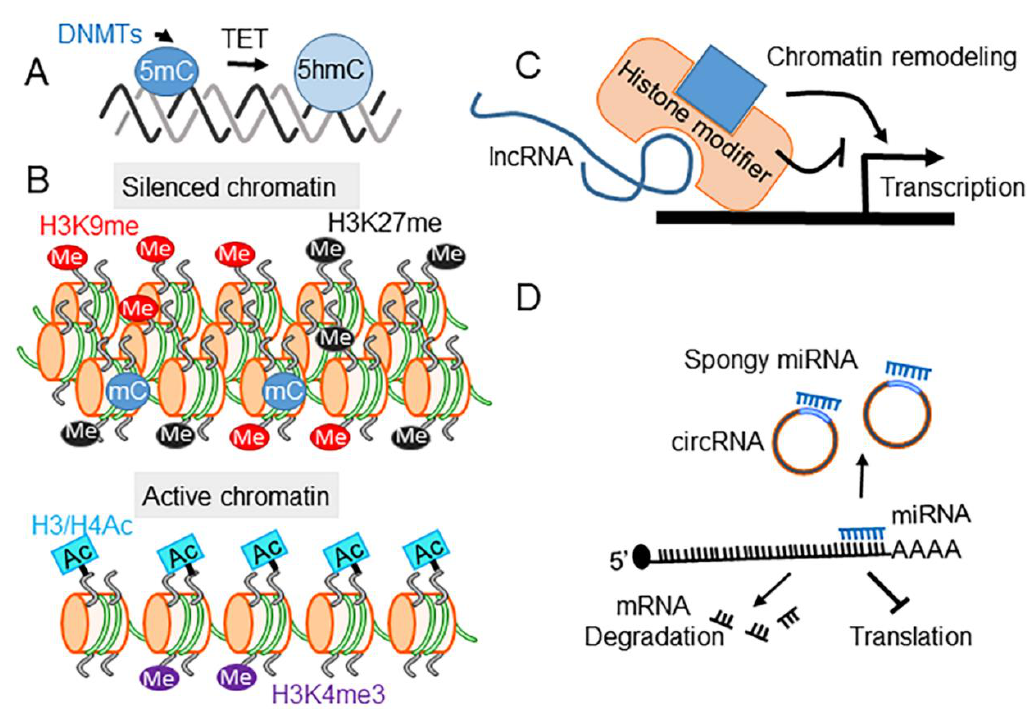
Figure 1. Schematic mechanisms of epigenetic mechanisms. ( A ) DNA methylation typically occurs at CpG dinucleotides (5mC), in which cytosines are methylated by DNA methyltransferases (DNMTs). The added methyl group(s) can be converted to hydroxymethyl (5hmC) by TET family proteins. Both 5mC and 5hmC are abundant in the brain. ( B ) Histone modifications mark the transcriptionally active or silenced chromatin states. Methylation and acetylation are two major studied histone modifications in drugs of abuse. The silenced chromatin is enriched with histone H3 lysine 9 (H3K9me) and 27 (H3K27me) methylations, whereas the active chromatin is covered by hyper- acetylated histones and tri-methylated histone H3 lysine 4 (H3K4me3). ( C ) The long noncoding RNAs (lncRNAs) are likely involved in recruiting histone modifying enzymes that add or remove histone marks that control the local chromatin status, thereby, affecting transcription, either posi- tively or negatively. ( D ) microRNAs (miRNAs) down-regulate mRNA levels either by mediating the degradation of mRNA or blocking translation. Circular RNAs (circRNAs) are a new class of ncRNA that may antagonize the function of miRNA by sponging and may also have gene regulation potency.